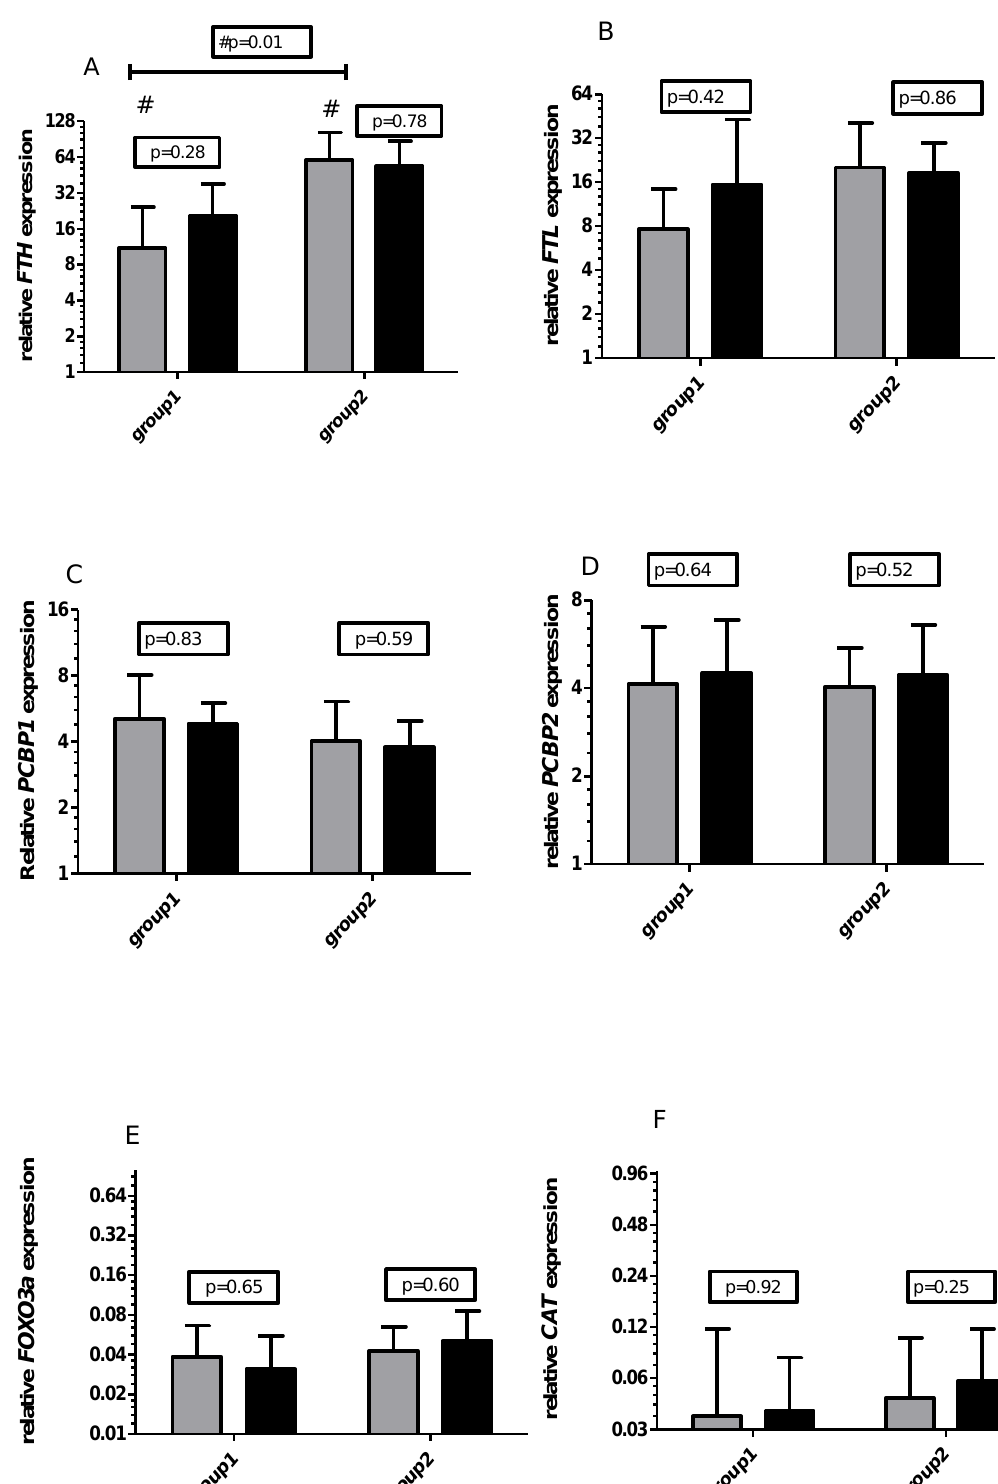
Figure 2. Changes in relative expression (2^) of FTH ( A ), FTL ( B ), PCBP1 ( C ), PCBP2 ( D ), FOXO3a ( E ), and CAT ( F ) before (grey bars) and after 6 weeks (dark bars) unsupplemented training period. # significant differences between groups. All mRNA expressed as 2^ relative expression/TUBB.